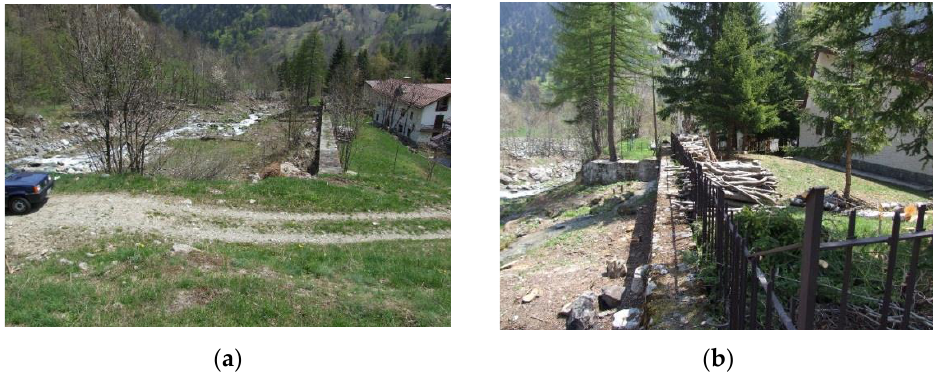
Figure 12. Image of the embankment wall ( a ) and of the erosion repulsion structure ( b ), respectively, longitudinal and transversal to the direction of the water flows, realized after 1957 and still representing the defense system for the built-up area partly visible on the right bank.